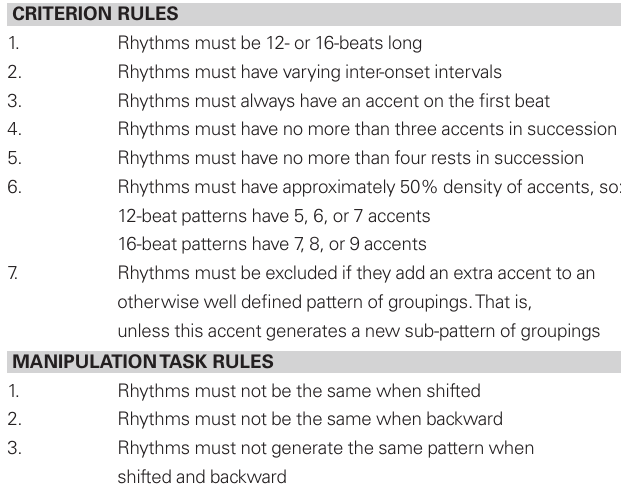
Table 1 | Criteria used to select the rhythmic